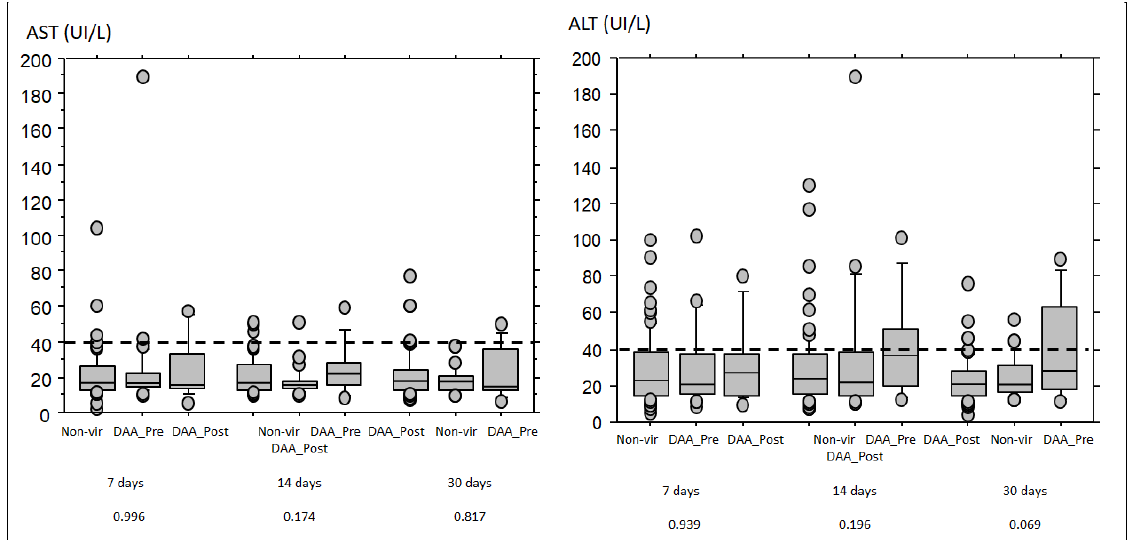
Figure 3. Box plot of the evolution of liver enzymes (AST ( left ) and ALT ( right )) in patients receiving grafts from non ‐ viremic donors ( n = 75) and viremic donors either starting DAA treatment before ( n = 26) or after transplantation ( n = 15). p ‐ values by Kruskal–Wallis test are depicted at the bottom of the figure.